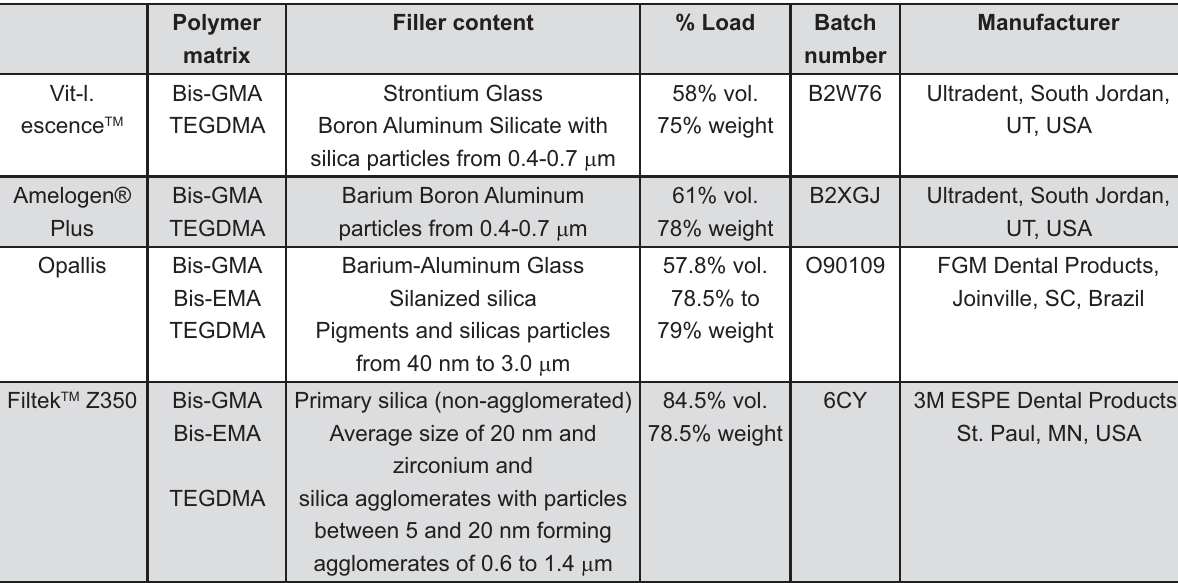
Figure 1- Main characteristics of the composite resins used in the study